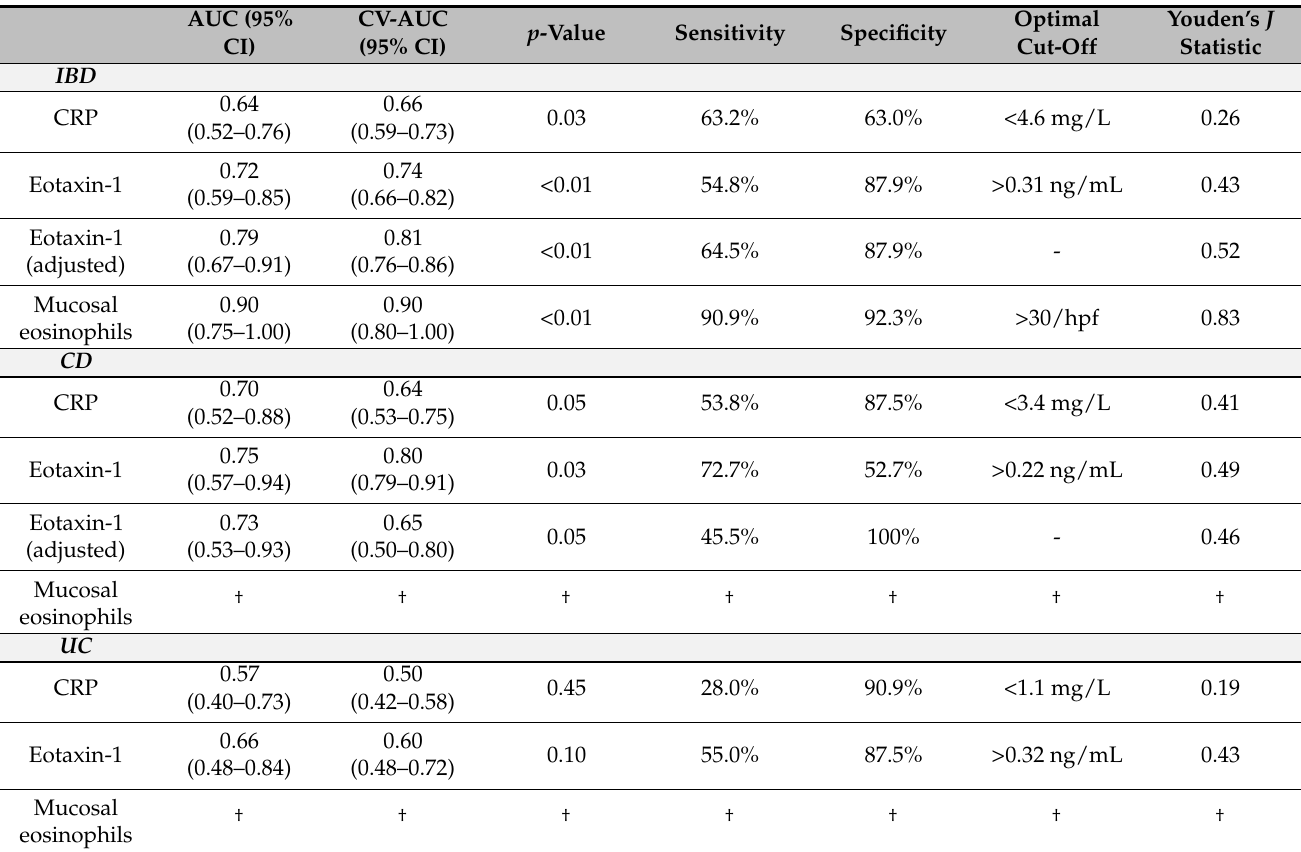
Table 4. Receiver operating characteristics (ROC) analysis demonstrating discriminative values of mucosal eosinophil abundance, serum eotaxin-1 levels (unadjusted and adjusted models), and serum CRP levels with regard to clinical response to vedolizumab induction therapy. Data presented in this table are based on patients from the discovery